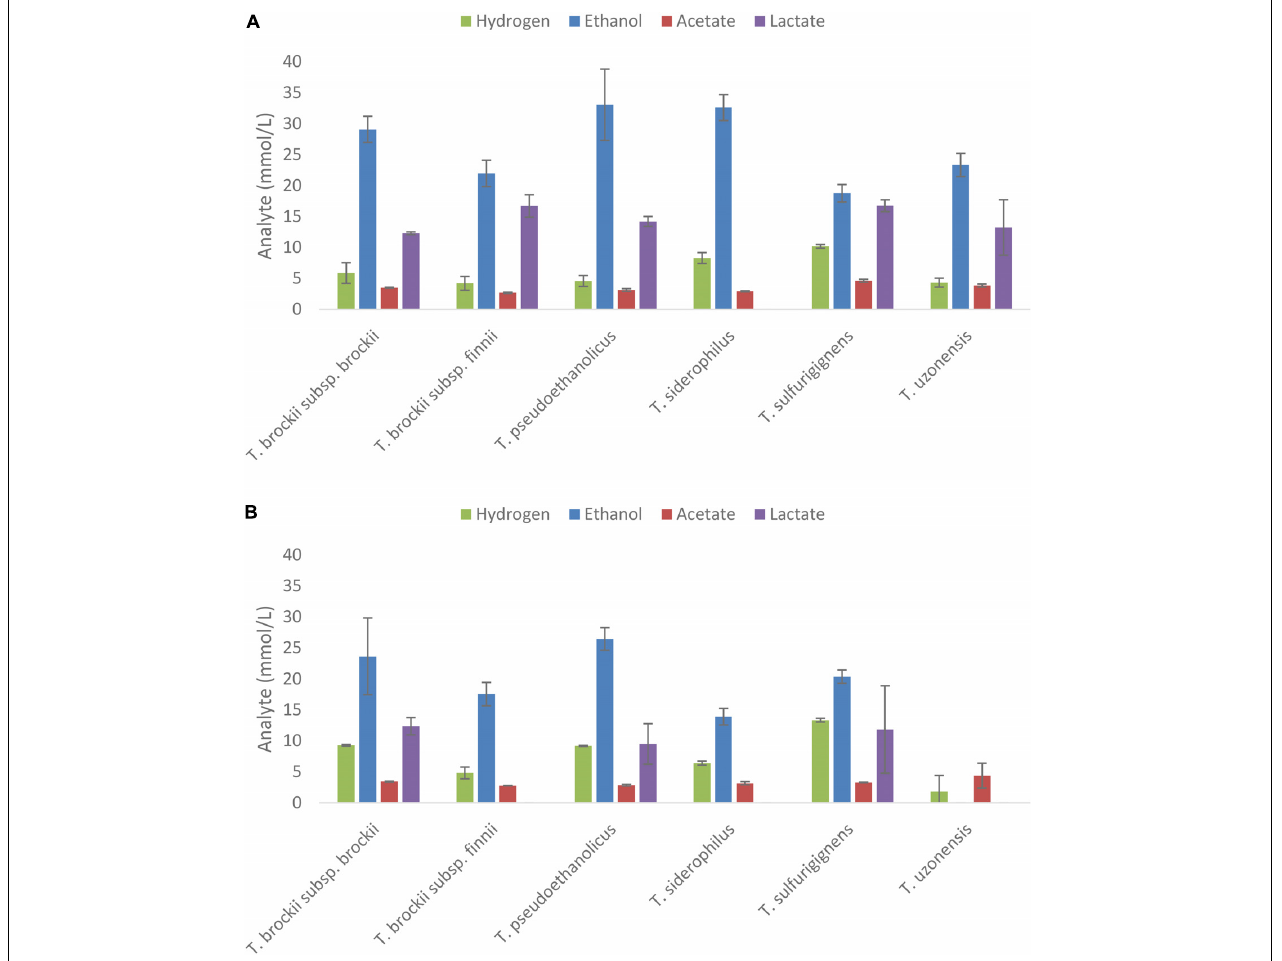
FIGURE 4 | Fermentation products after 5 days from selected thermophilic Clostridia on extracts of Ascophyllum nodosum (A) and Laminaria digitata (B) adjusted to 20 mM mannitol equivalent. End products were analyzed after 10 days of fermentation; values represent the average of triplicate fermentations with SD presented as error